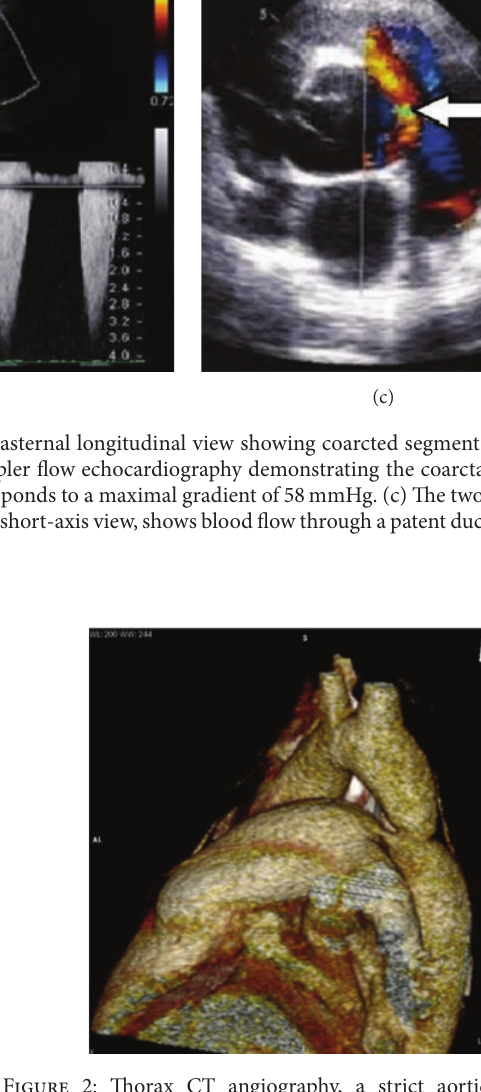
Figure 2: Thorax CT angiography, a strict aortic coarctation proximal part of descending aorta, and a small size patent ductus arteriosus were